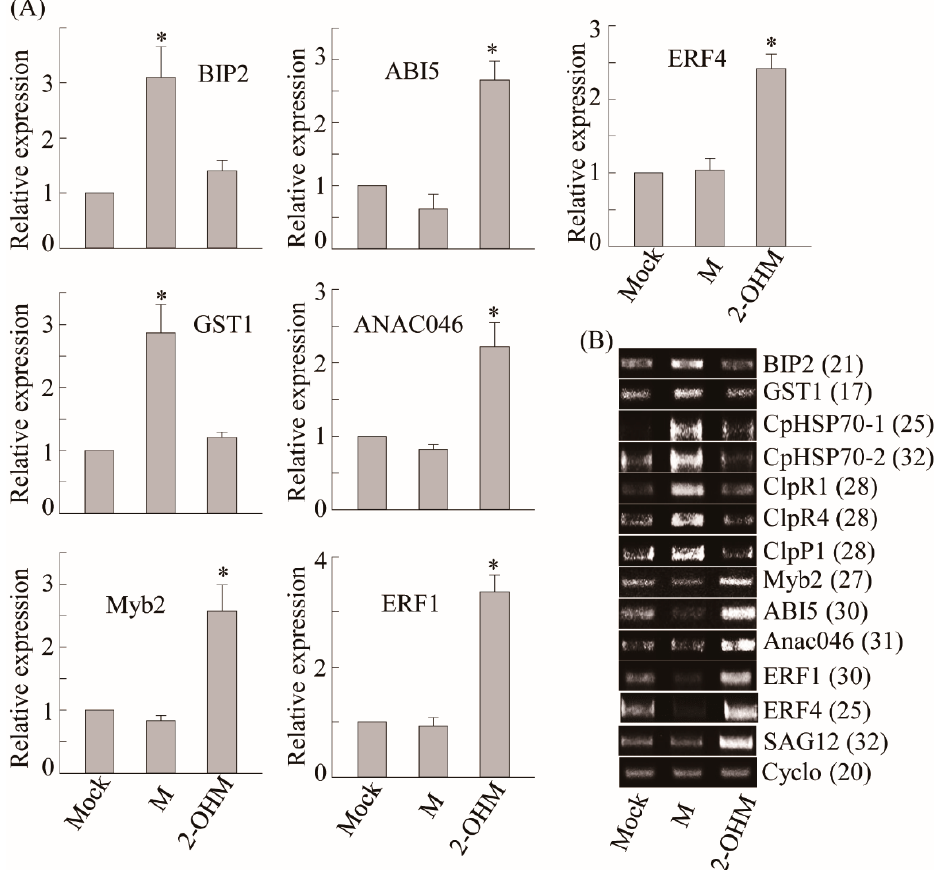
Figure 4. ( A ) Real-time PCR (qRT-PCR) analysis results for various genes involved in cell homeostasis and ABA and ET signaling in arabidopsis leaves in response to melatonin or 2-OHM treatment. ( B ) RT-PCR analysis results. Some genes analyzed by qRT-PCR were further analyzed by RT-PCR for clarification. Six-week-old Col-0 WT arabidopsis leaves (first or second leaves) were infiltrated with either melatonin (M; 1 µ M) or 2-OHM (1 µ M) and then incubated under dim light conditions (7 µ mol m − 2 s − 1 ) for 2 h before leaves were collected. Mock treatment consisted of 5 mM MgCl 2 (2 mM MES, pH 5.6). Expression levels were normalized to Cyclo for qRT-PCR. Asterisks indicate significant differences from the mock control as determined by Tukey’s post-hoc HSD test at a level of p < 0.05. GenBank accession numbers were as follows: BIP2 (AT5g42020), GST1 (AT1g02920), CpHSP70.1 (AT4g24280), CpHSP70.2 (AT5g49910), ClpR1 (AT1g49970), ClpR4 (AT4g17040), ClpP1 (ATCg00670), Myb2 (AT2g47190), ABI5 (AT2g36270), Anac046 (AT3g04060), ERF1 (AT3g23240), ERF4 (AT3g15210), SAG12 (AT5g45890), and Cyclo (AT4g38740). Numbers in parentheses indicate the number of PCR